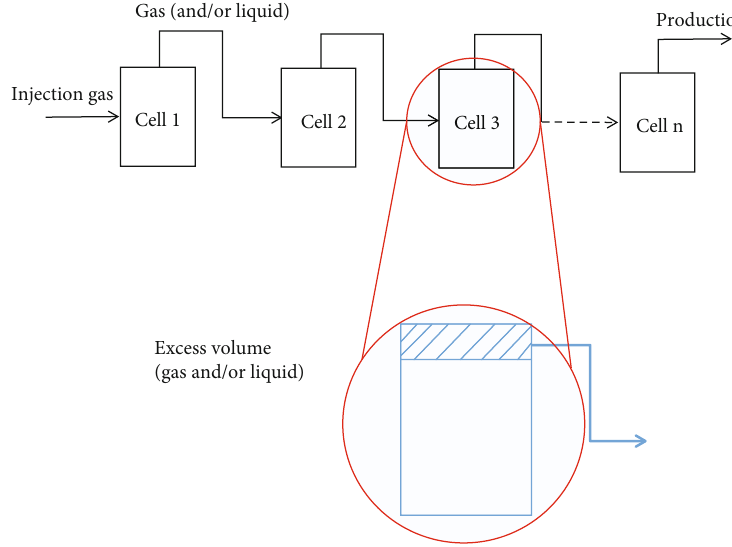
Figure 1: Schematic diagram of the MMC